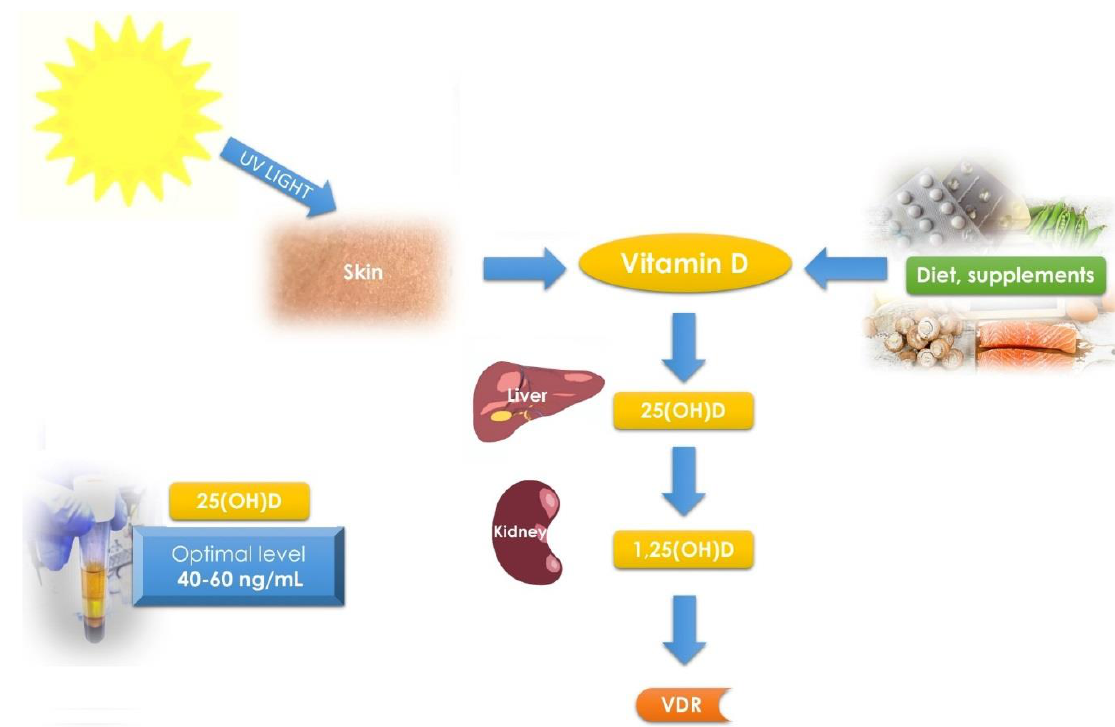
Figure 1. Vitamin D metabolism and schematic pathways. Diet, supplements and sunlight are the major source of vitamin D in humans. Vitamin D is synthetized in skin from 7-dehydrocholesterol. In further steps liver converts it to 25(OH)D and then kidney to 1,25(OH)D. Optimal vitamin D serum levels were described as 25(OH)D of 40–60 ng/mL [39].